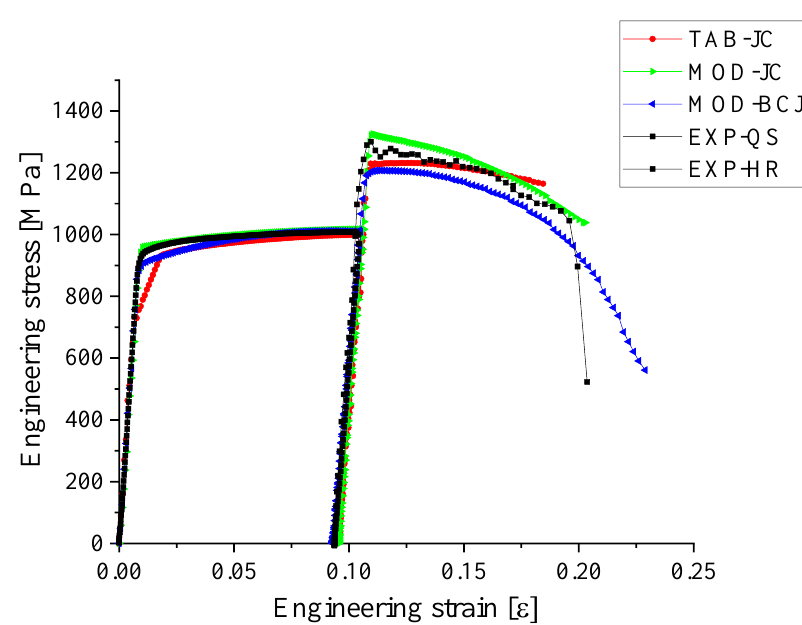
Fig. 7. Comparison of the experimental and numerical results using phenomenological Models for 10%